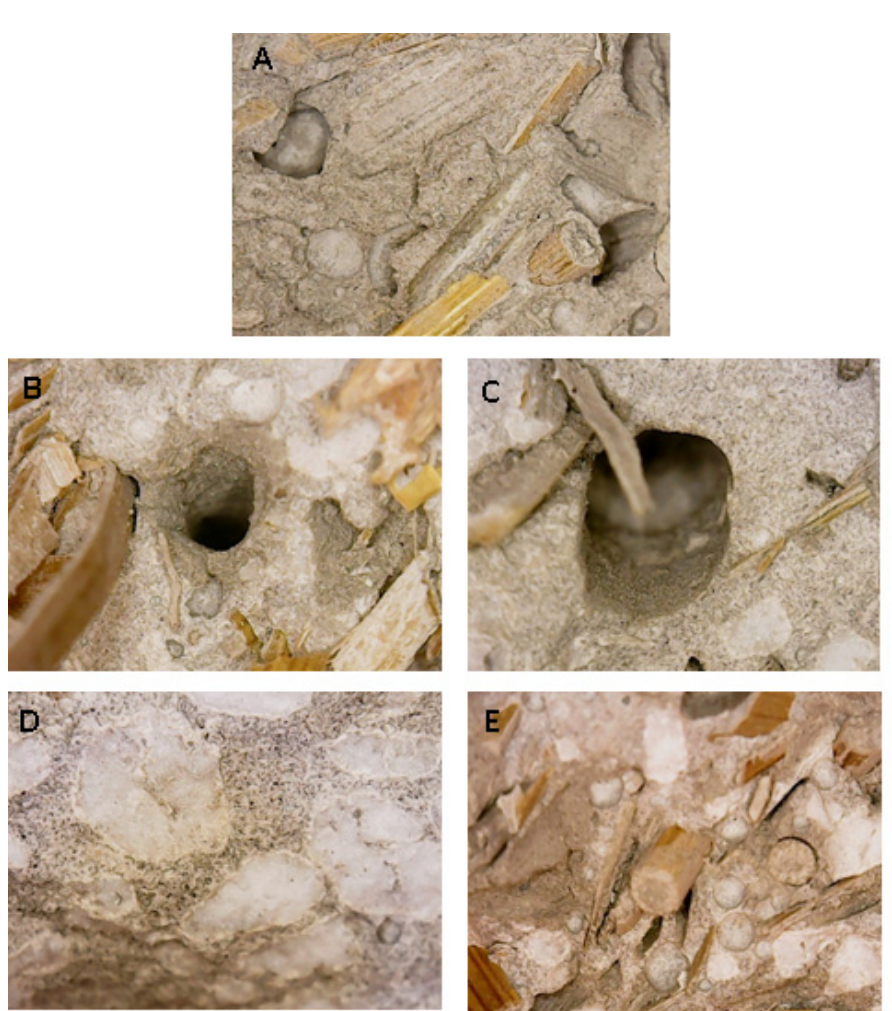
Figure 9. Failure plane of the ( A ) S1 sample, ( B ) and ( C ) holes caused by the pull-out of the straw, sections of the ( D ) P sample and of the ( E ) P/S1 sample.